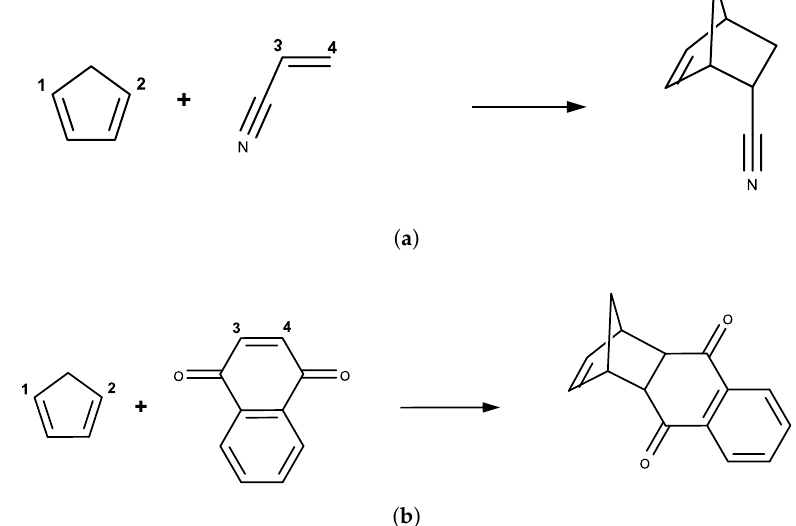
Figure 2. Diels–Alder reactions between: ( a ) cyclopentadiene and acrylonitrile; and ( b ) cyclopentadiene and 1-4-naphthoquinone, where η 1 = d C 1 C 3 and η 2 = d C 2 C 4 were chosen as the two-dimensional reaction